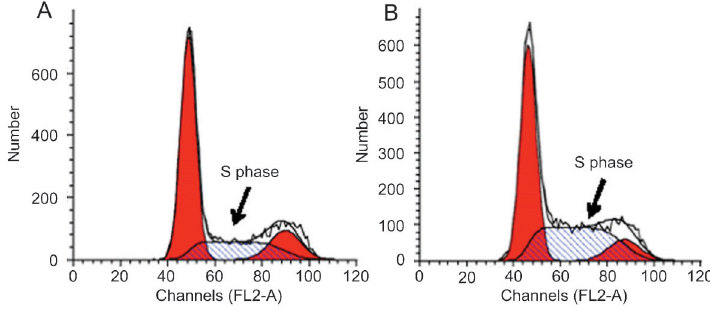
Figure 3. A , Apoptosis rates of normal HUVECs. B , HUVECs incubated with Ox-LDL (100 m g/mL) for 24 h. Rates increased from 5.26% in control to 15.69% in the Ox-LDL-treated cells. HUVECs: human umbilical vein endothelial cells; Ox-LDL: oxidative low-density lipoprotein; PI: propidium